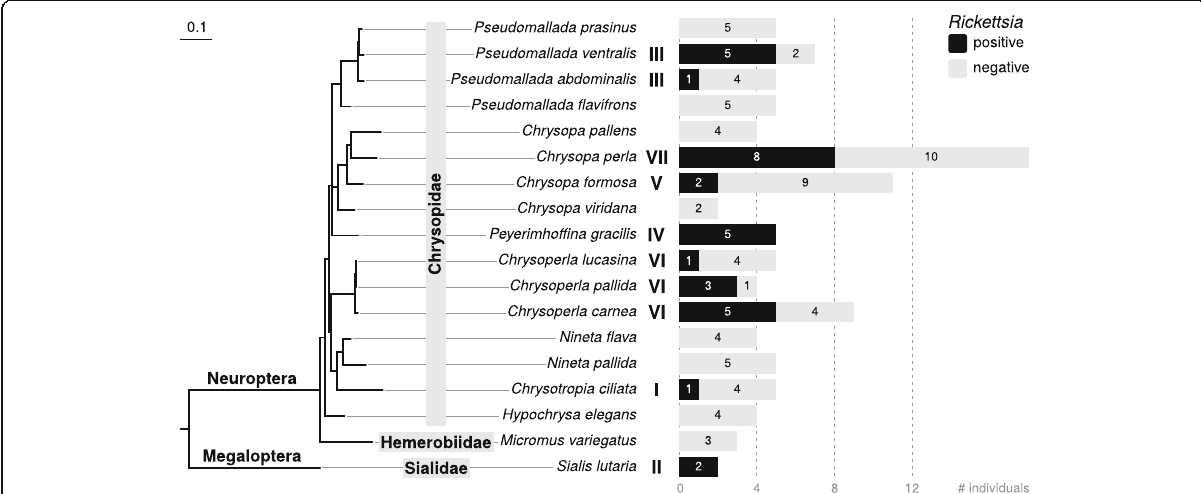
Fig. 1 Result of Rickettsia screening in lacewings and allies. Maximum likelihood tree shows phylogenetic relationships of investigated species based on a 657 bp alignment of the mitochondrial cytochrome oxidase subunit 1 gene. For each of the species, a bar chart shows the number of sampled individuals, partitioned in Rickettsia positive individuals ( black part of bars ) and Rickettsia negative individuals ( grey part of bars